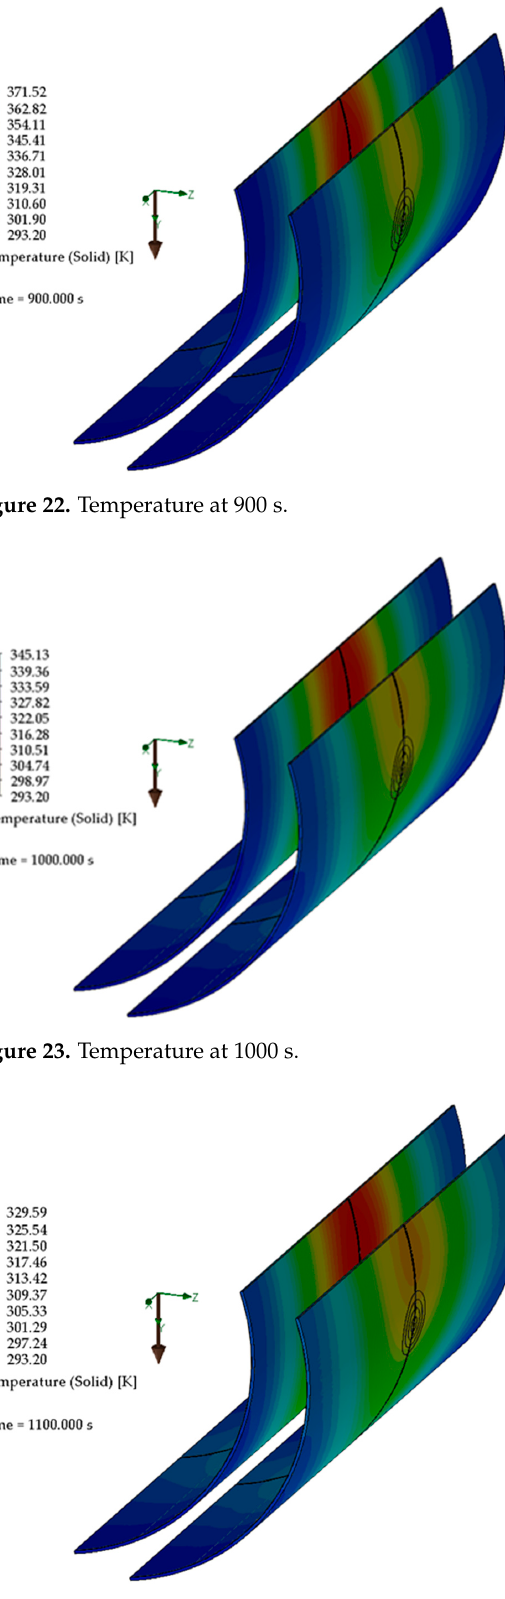
Figure 21. Temperature at 800 s.